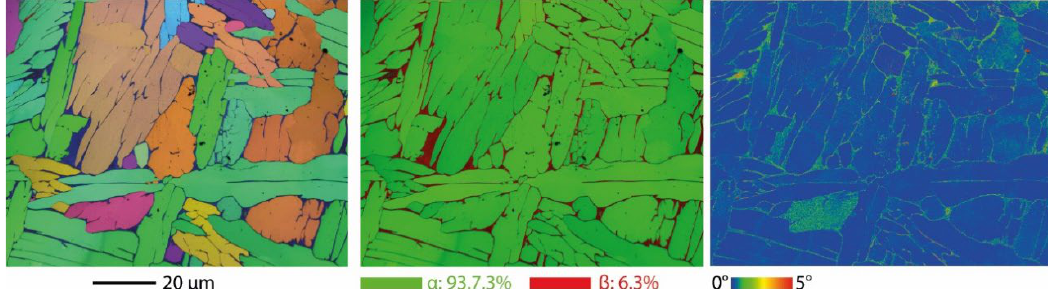
Figure 9. The SEM-EBSD mapping of the LPBF-processed Ti6Al4V